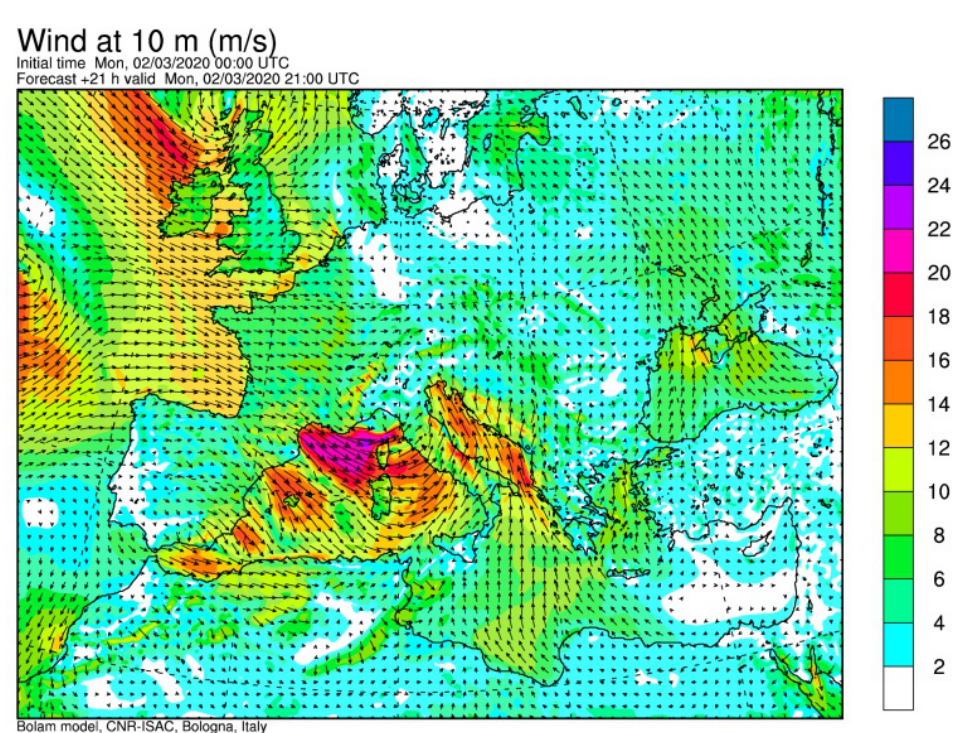
Figure A15. Map of the wind at 10 m height over the Mediterranean basin, as forecast for 2 March 2020 at 21 p.m. by the BOLAM model. The arrows indicate the wind direction and the wind speed is shown in the colour